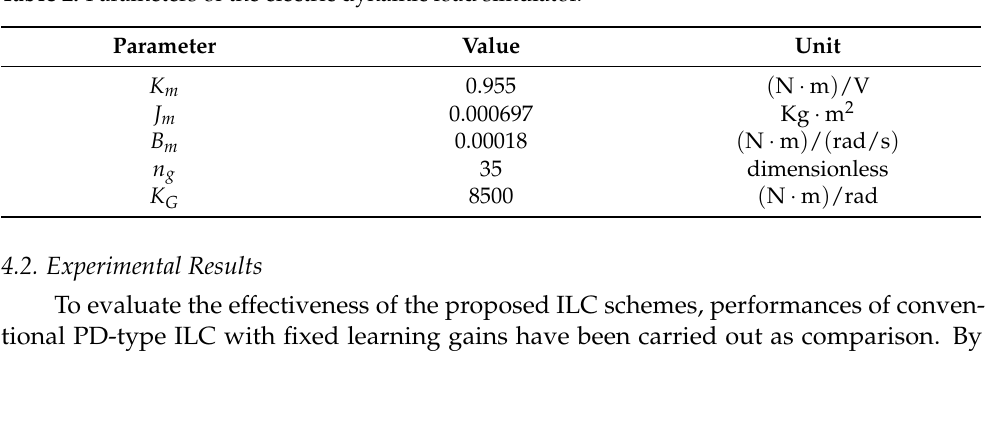
Table 2. Parameters of the electric dynamic load